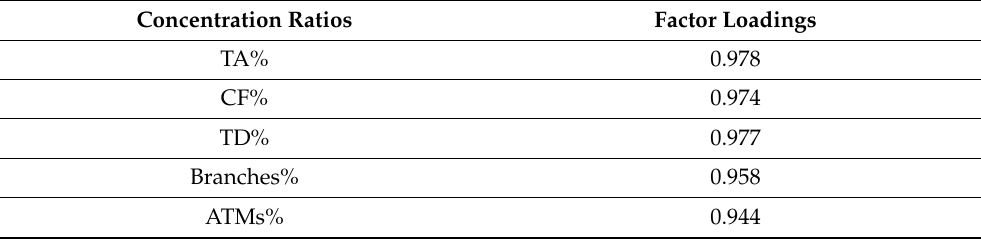
Table 7. Concentration ratios and factor loadings defining the OC construct.